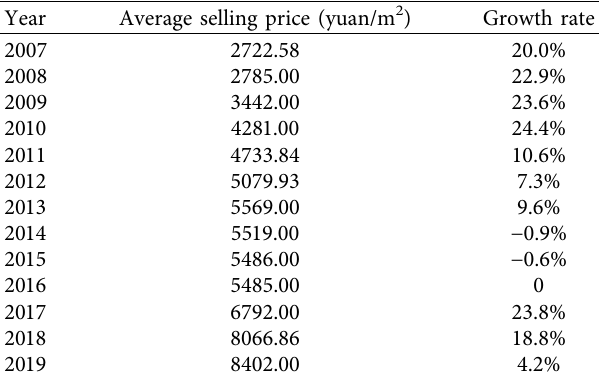
Table 5: Chongqing house price and growth rate.